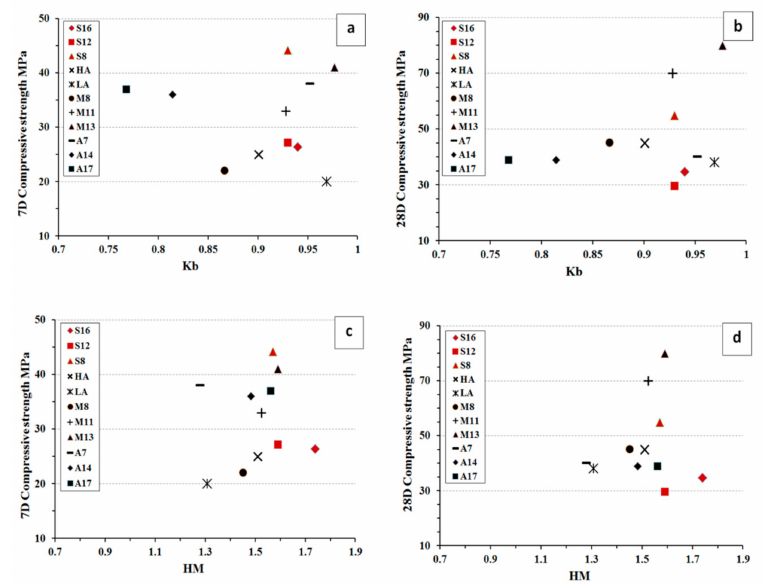
Figure 15. Dependencies between ( a , b ) Kb with 7-day and 28-day compressive strength respectively, ( c , d ) HM with 7-day, 28-day compressive strength respectively. Comparative results were adapted from others